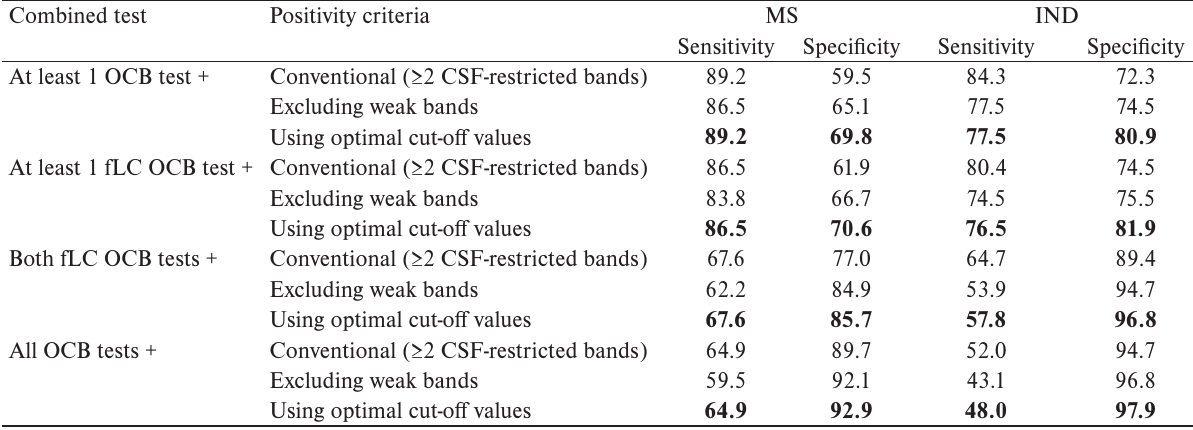
Table 3. Sensitivity and specificity of CSF-restricted OCB combined tests for the diagnosis of MS or inflammatory neurologic disorder in general, using different cut-off